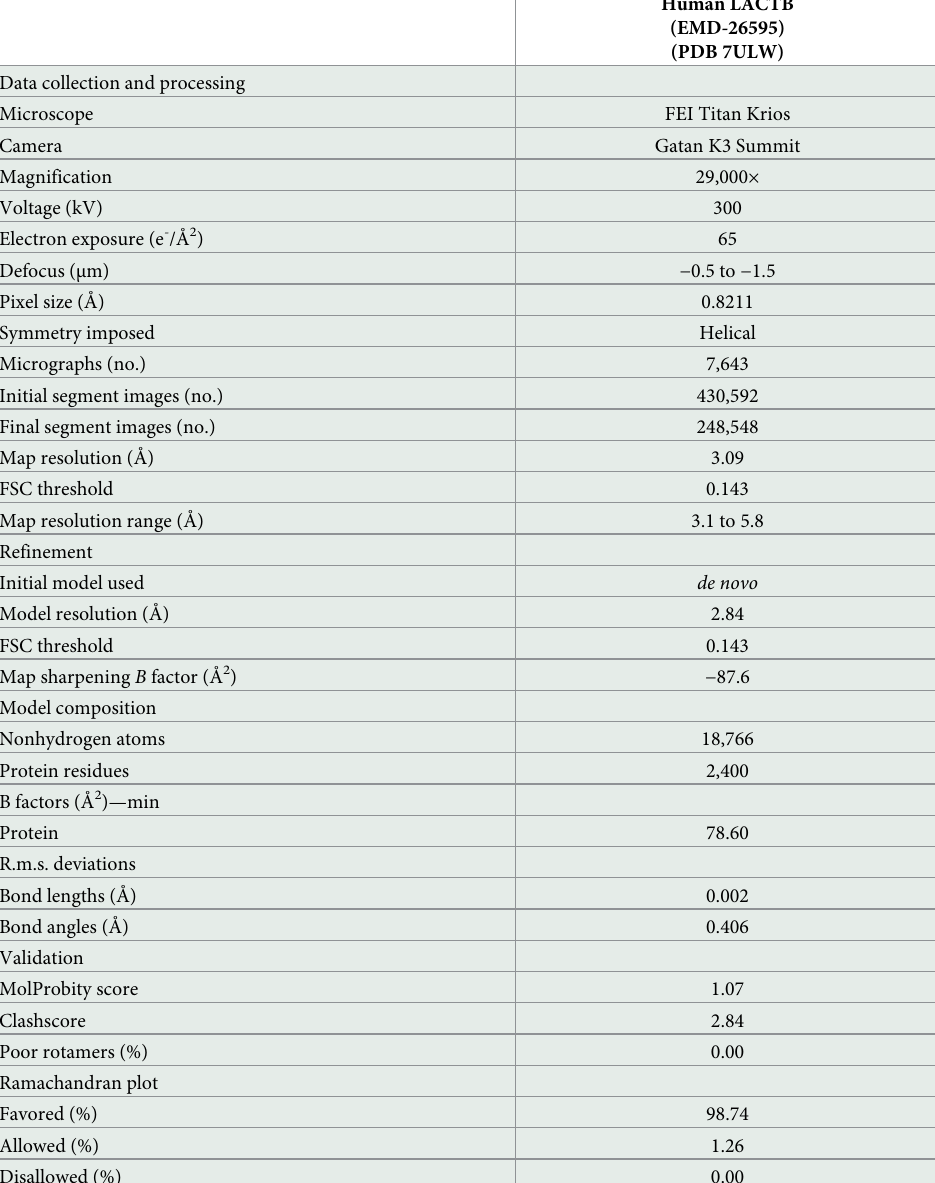
Table 1. CryoEM data collection, refinement, and validation statistics.